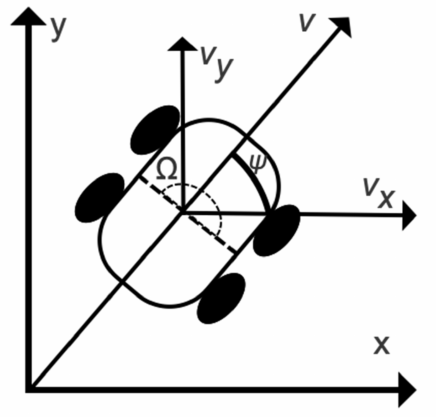
Figure 3. Motion model of the